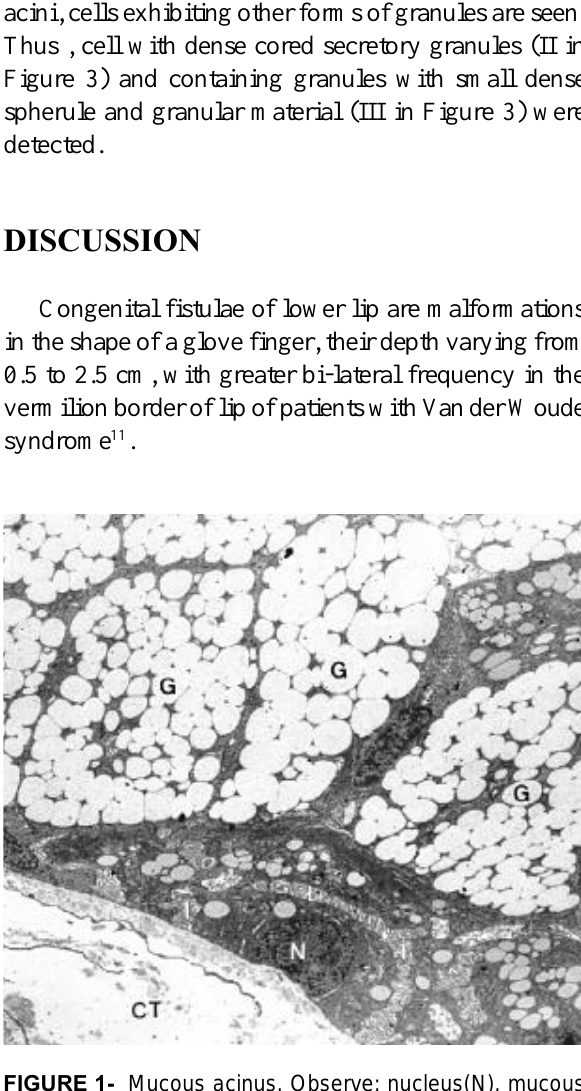
FIGURE 1- Mucous acinus. Observe: nucleus(N), mucous secretory granules(G), intercelular spaces with interdigitations(I) and interacinar connective tissue. x